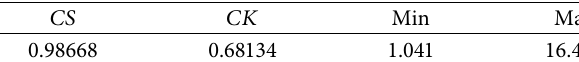
Table 11: Descriptive statistics of COVID-19 fatality rate data.